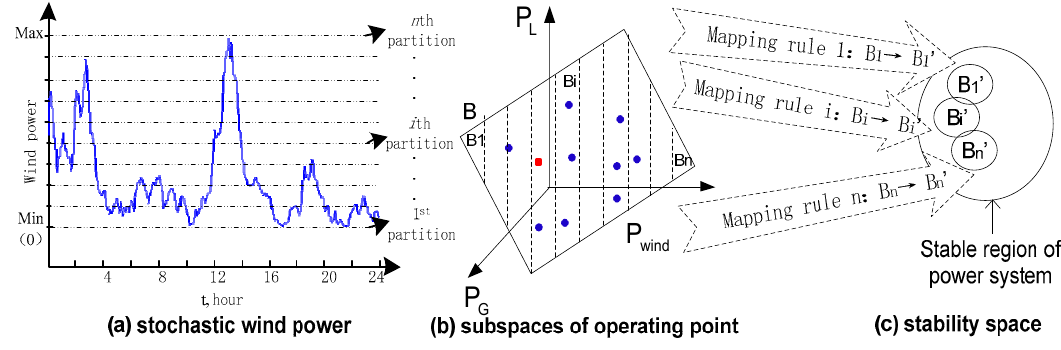
Figure 1. The formation of subspaces.